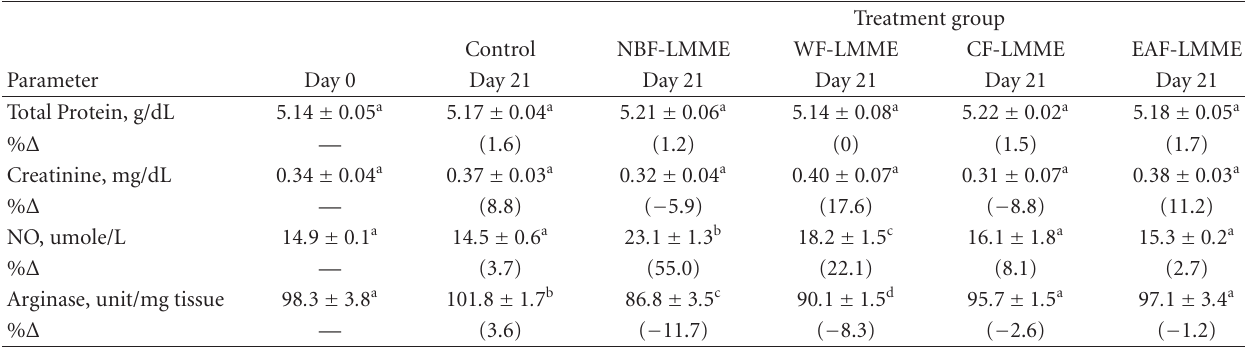
Table 2: Changes in cardiac arginase activity and serum total protein, creatinine, and nitric oxide in mice orally administered with the various fractions recovered from Loranthus micranthus methanolic leaf extract for 21